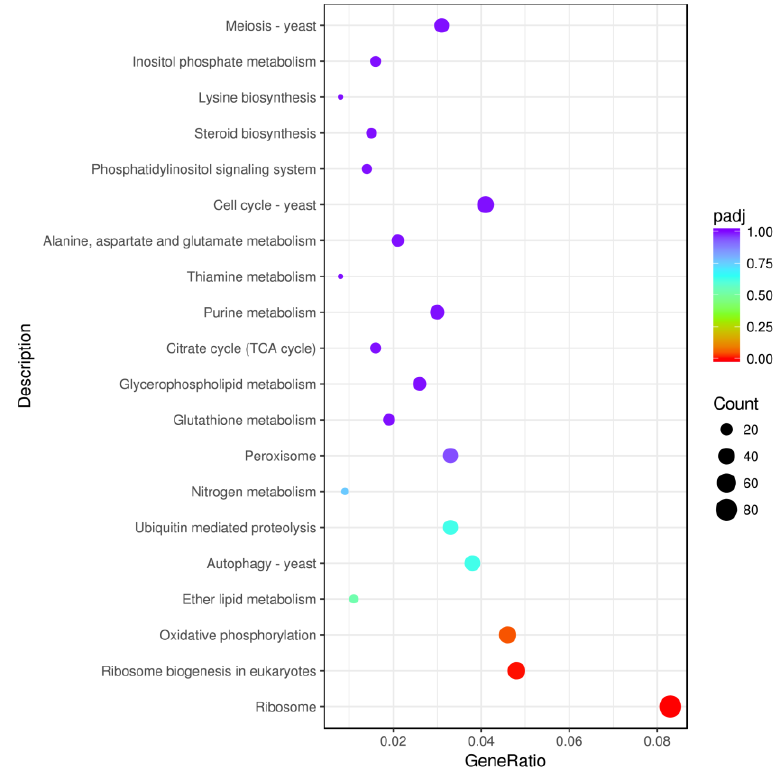
Figure 8. KEGG enrichment analysis. The abscissa shows the ratio of the number of differentially expressed genes annotated using the KEGG pathway to the total number of differentially expressed genes. The ordinate shows the KEGG pathways. The size of the dots represents the number of genes annotated to the KEGG pathway and the color from red to purple represents the significance of enrichment.